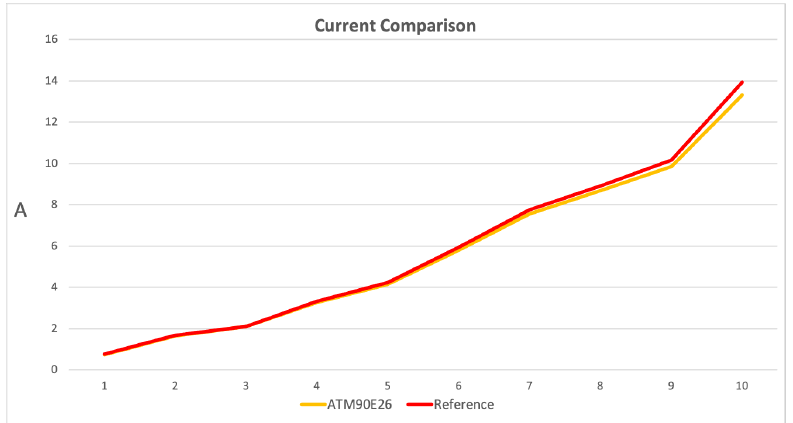
Figure 14. Comparison of current measurements: Measurements are on the vertical axis in Ampere, while the horizontal axis expresses the number of measures performed.